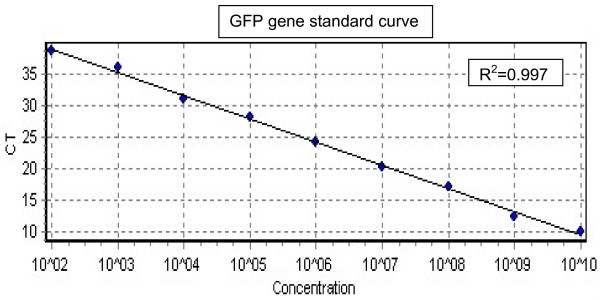
Standard curve plot of log10 diluted in vitro transcribed RNA for GFP.